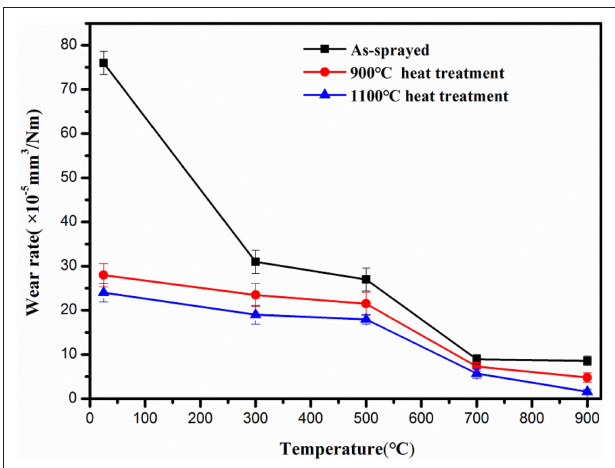
FIGURE 10 | Wear rate of coating at different friction test temperatures.